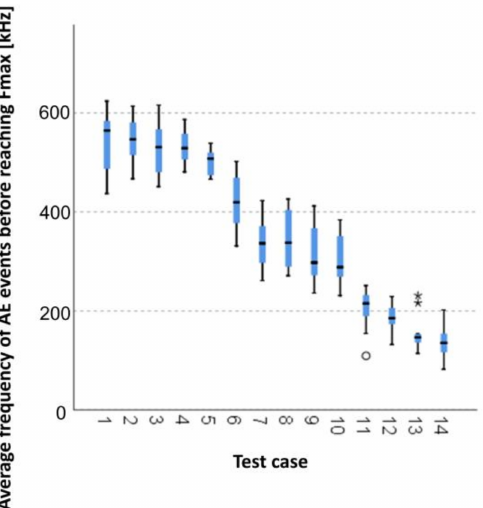
Figure 16. Graphic presentation of the Kruskal–Wallis test results for independent samples: average frequency of AE events before reaching F max .